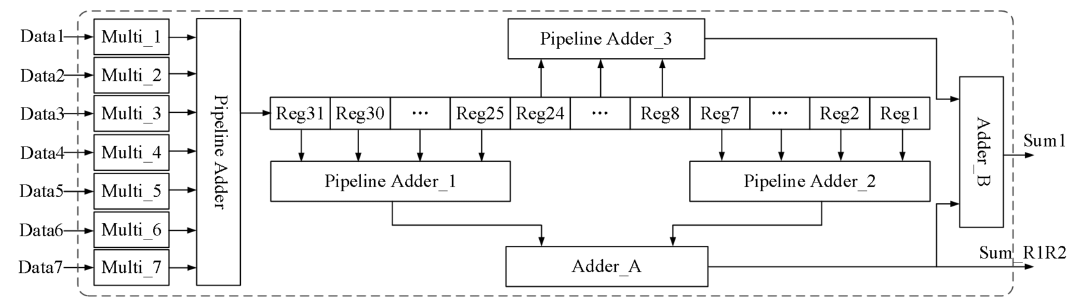
Figure 15. Calculating the sum of squares of